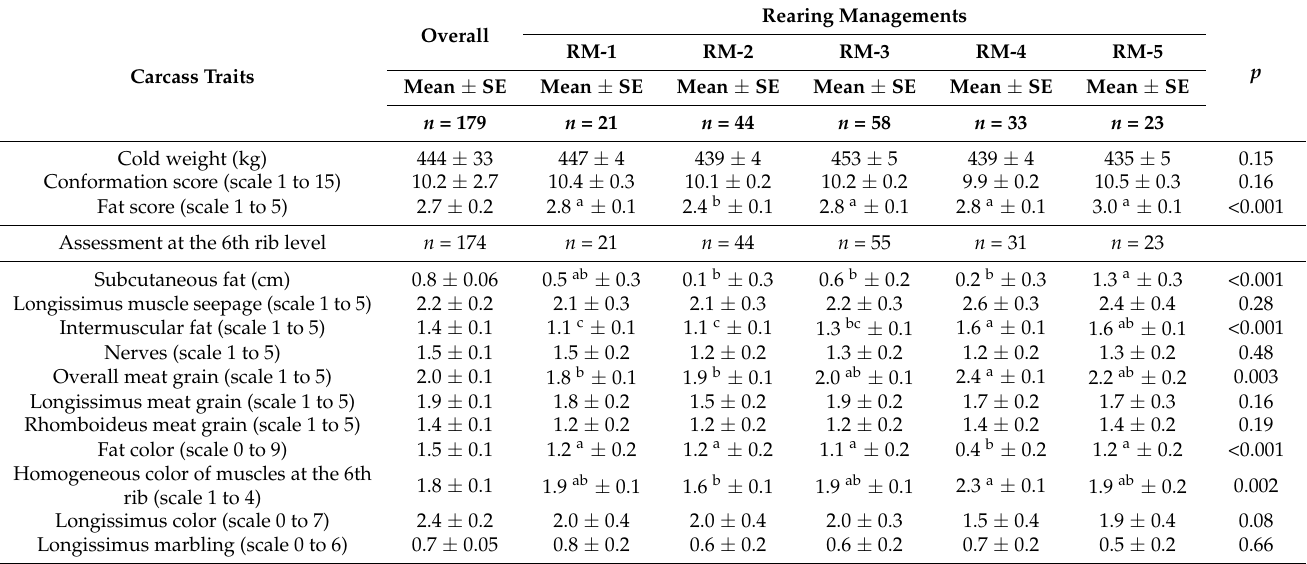
Table 6. Effects of the five rearing managements (RM), applied throughout the young bulls’ life, on the carcass